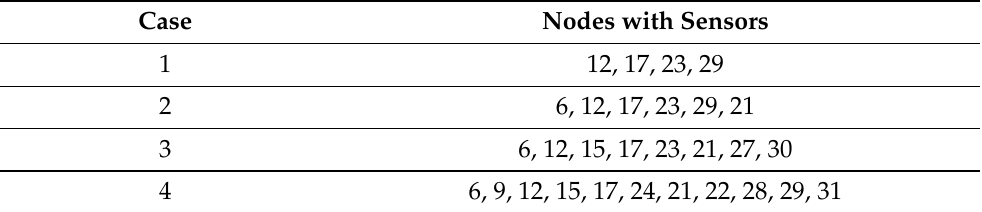
Table 2. Nodes with